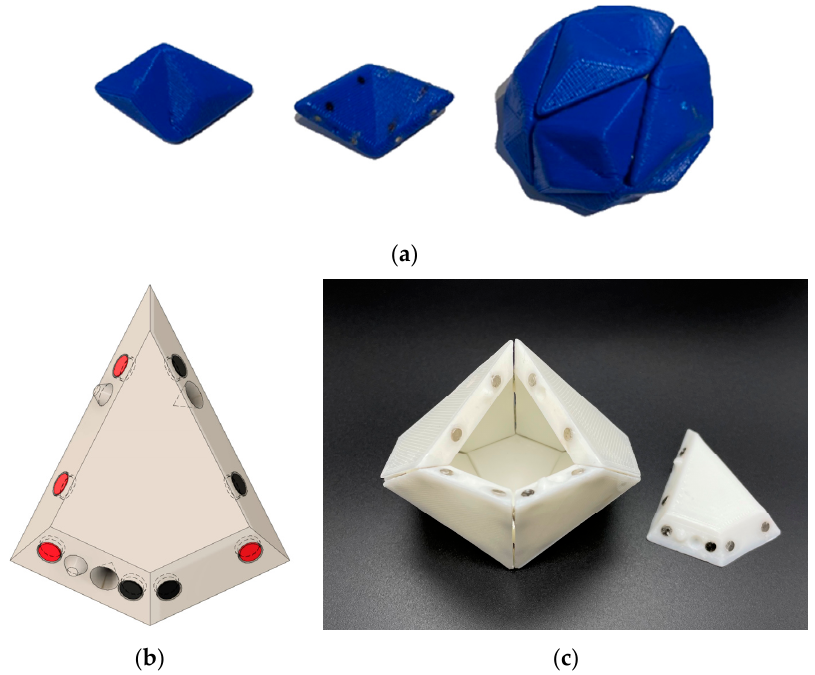
Figure 12. Ten rhombic subunits can self-assemble into a decahedron model of an icosahedral viral capsid. ( a ) A self-assembling decahedron constructed by keeping ten pairs of the subunits in Figure 8 conjoined; ( b ) a rhombic decahedron subunit with its magnet map, and hole and peg arrangement, for 3D printing, image created in Fusion 360; ( c ) a view of an incompletely assembled decahedron; The knobs and holes are to force the long edges to assemble in only one direction. Without them it would be possible for the long edge with black magnets to be attracted to the long edge with red magnets in an “upside-down” configuration. These magnet maps are more complicated than the platonic solid ones and this is where we spent a significant amount of time planning for the T1 model. Because of this model ( b , c ) assembles faster and with a higher frequency of completion than model ( a ). We